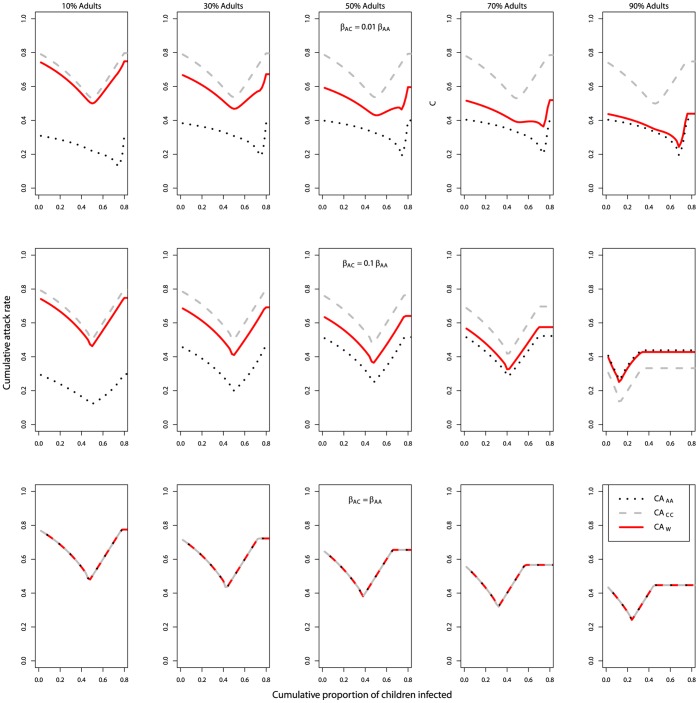
Cumulative attack rates against children’s population trigger in the presence of inter-group transmission.Everything else as described in Figure 8 caption. Note that again the x-axis does not go beyond a threshold level of 0.8 since even an unmitigated outbreak (even in the absence of coupling) did not reach a higher attack rate among the children and therefore intervention would not be triggered.